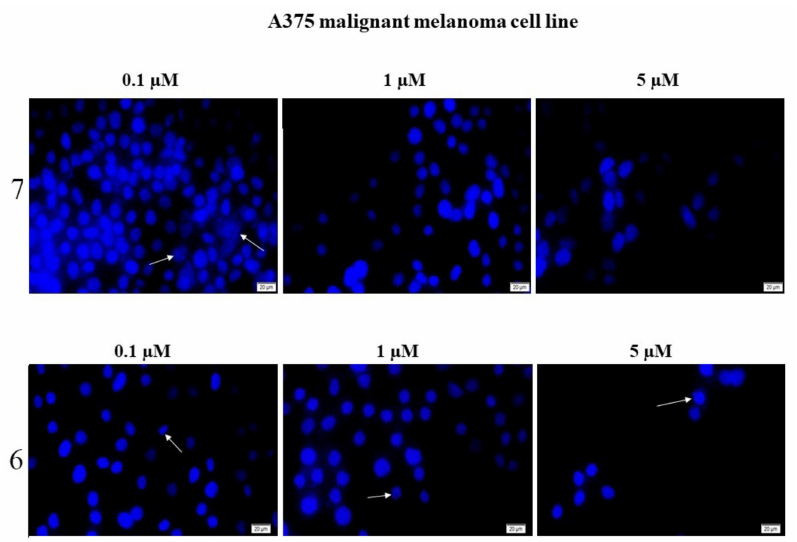
Figure 6. Effect of compounds 6 and 7 (0.1, 1 and 5 uM) and DMSO (0.1, 1 and 5 uM) after 24 h of stimulation on the A375—DAPI staining. The white arrows indicate the apoptotic cells with nuclear fragmentation; figures are scaled at 20 µ m.